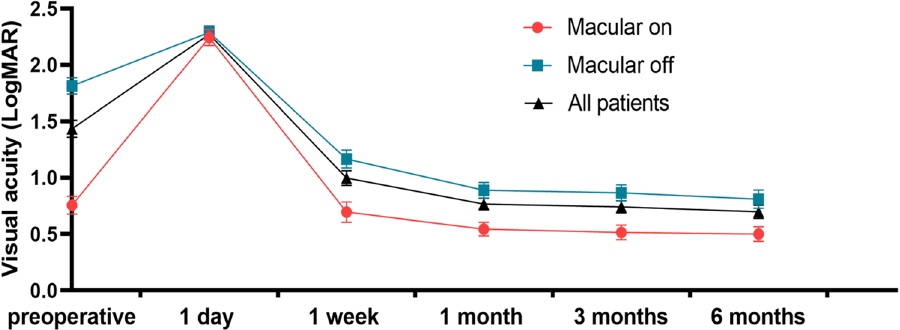
Figure 1. Visual outcome of patients undergone pars plana vitrectomy with air tamponade for rhegmatogenous retinal detachment.